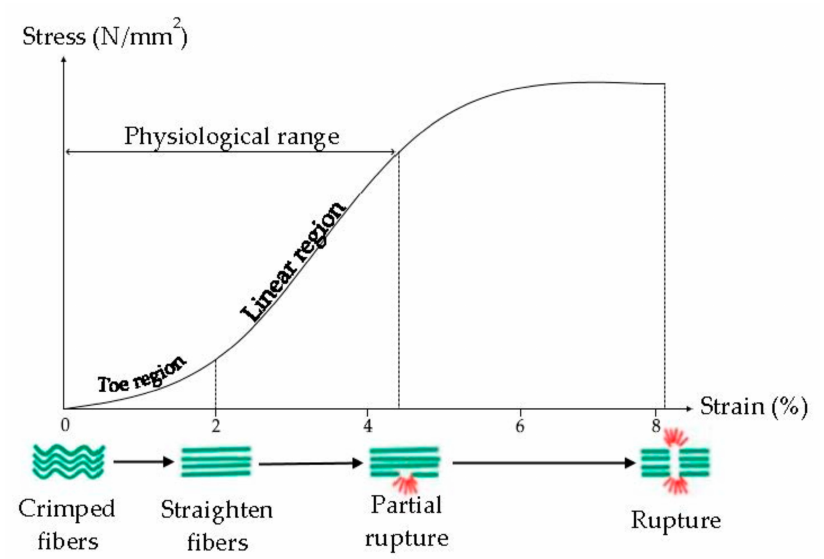
Figure 4. Mechanism of internal deformation of tendon. Modified from [37]. CC BY-NC-SA